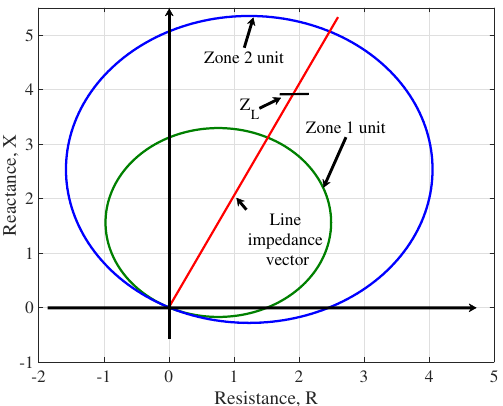
Figure 16. Operating characteristic of distance protection located at Node A